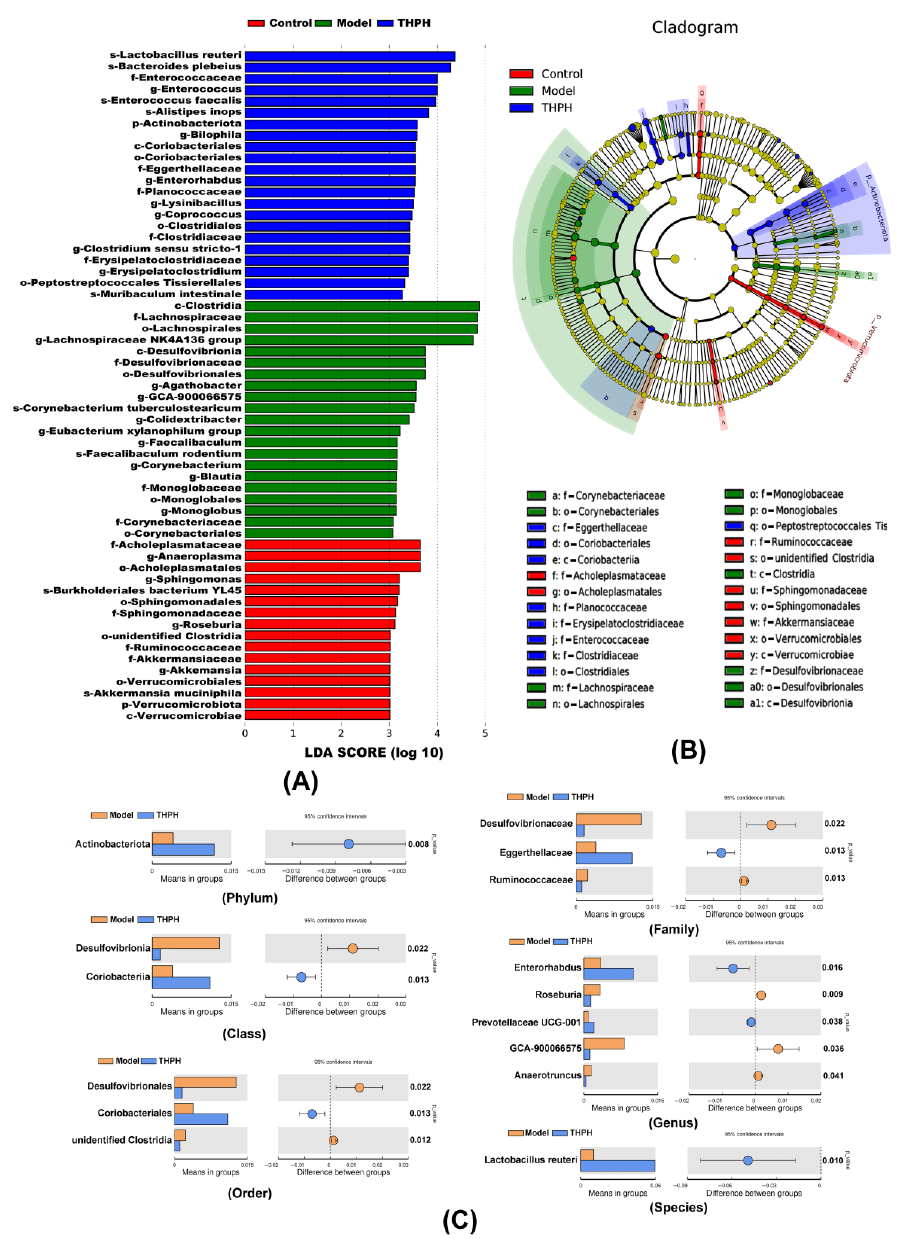
Figure 7. Effect of THPH on the significantly different bacteria in gut microbiota. ( A ) Linear discriminant analysis (LDA) of the gut microbiota in different groups. ( B ) Cladogram generated from linear discriminant analysis (LDA) showing the relationship between taxon. ( C ) Significantly different bacteria abundance maps between the model group and the THPH group at different taxonomic levels obtained by t -test.